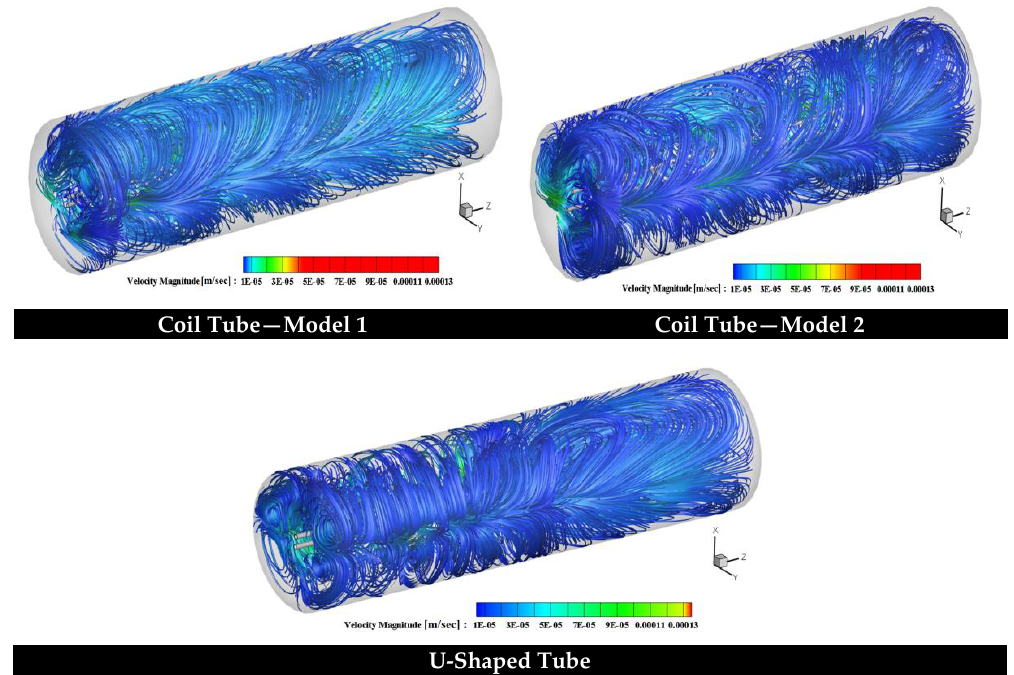
Figure 15. Three-dimensional streamlines with contours of the velocity magnitude for the three different cases in the horizontal position.